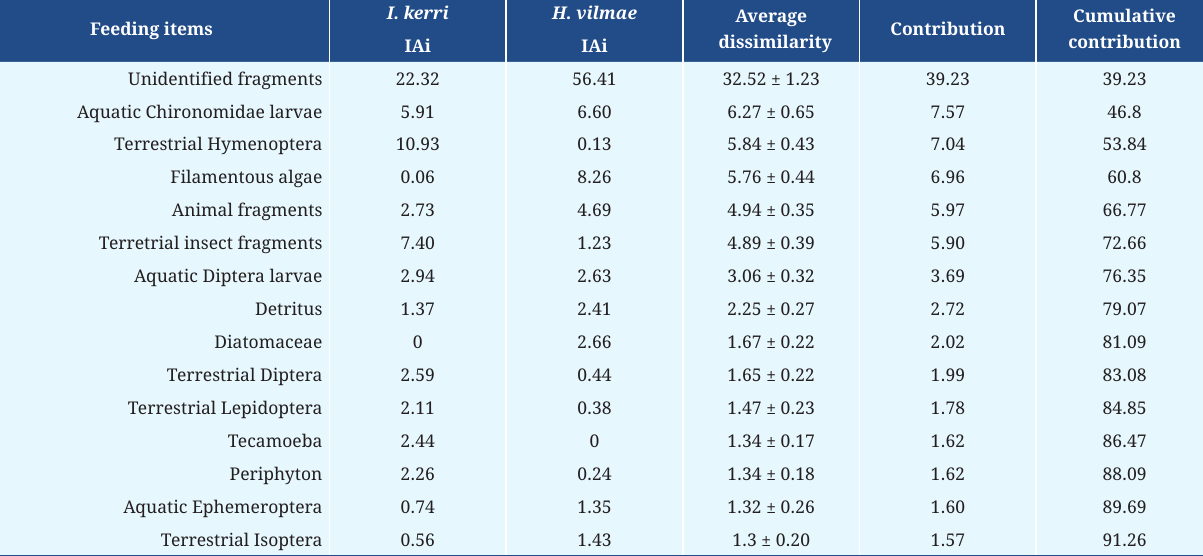
TABLE 4 | Average alimentary importance index (IAi), average dissimilarity between groups ± standard deviation, contribution (%), and cumulative contribution (%) of most important feeding items (listed in order of contribution) to the dissimilarity between Inpaichthys kerri and Hyphessobrycon vilmae in streams from the Aripuanã River basin (Mato Grosso State, Brazil).